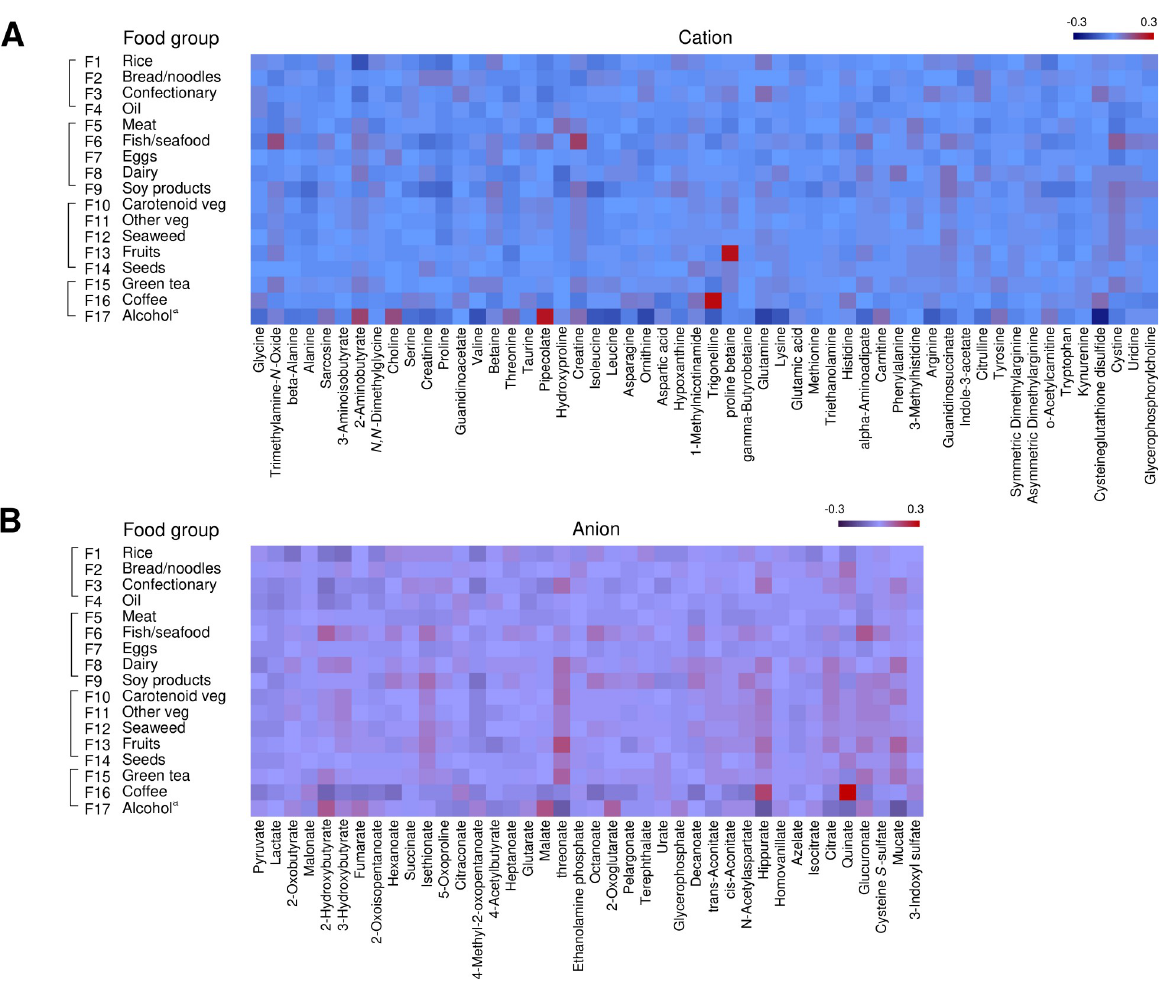
Fig 2. Correlation matrix diagram of the relationship between food groups and metabolites (n = 7,012). This heatmap was generated with partial rank-order Spearman correlation coefficients, controlling for sex, smoking, and total physical activity levels. (A) cation, (B) anion. a Data of male drinkers (n = 2,449) were used in the analysis for